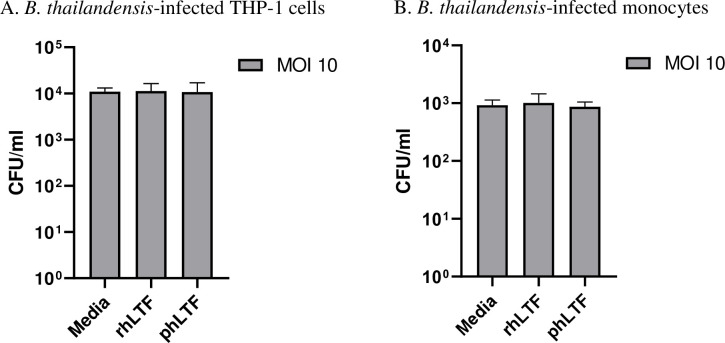
Lactoferrin does not alter intracellular replication of Bt in differentiated THP-1 cells or blood monocytes.Differentiated THP-1 cells (A) and primary blood monocytes (B) were infected with Bt at an MOI of 10 and 1 hour later were treated with either media or 100 μg/ml of rhLTF or phLTF, along with kanamycin (100 μg/ml). After 6 hours, cells were washed, lysed and intracellular bacteria were cultured and quantified in CFU/ml at 24 hours. Means ± standard deviations of duplicate or triplicate conditions are displayed. rhLTF vs media and phLTF vs media groups were compared by t-test (p>0.05 for all comparisons). One representative example of two or three independent experiments is shown.